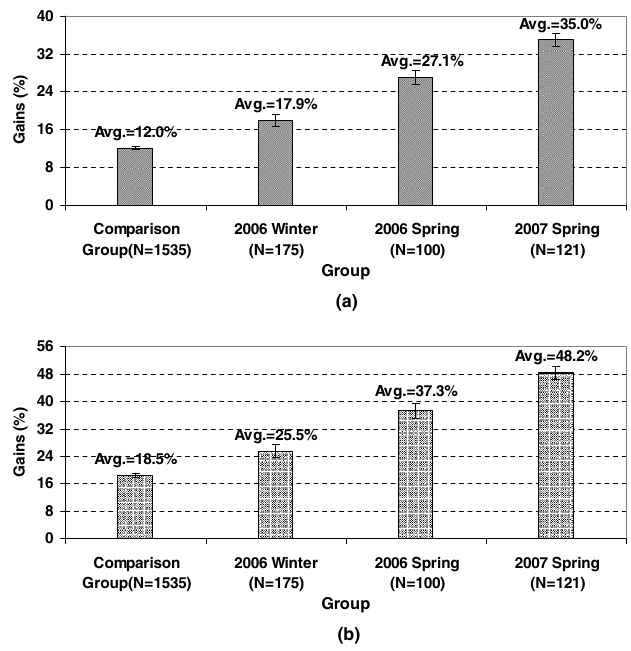
FIG. 5. (cid:1) a (cid:2) Absolute gains of the comparison group and the subsequent quarters. Note that the pre-test scores for quarters from 2006 to 2007 are rather similar (cid:1) see Fig. 4 (cid:2) . (cid:1) b (cid:2) Normalized gains of the comparison group and the subsequent quarters. Note that the error bars denote standard